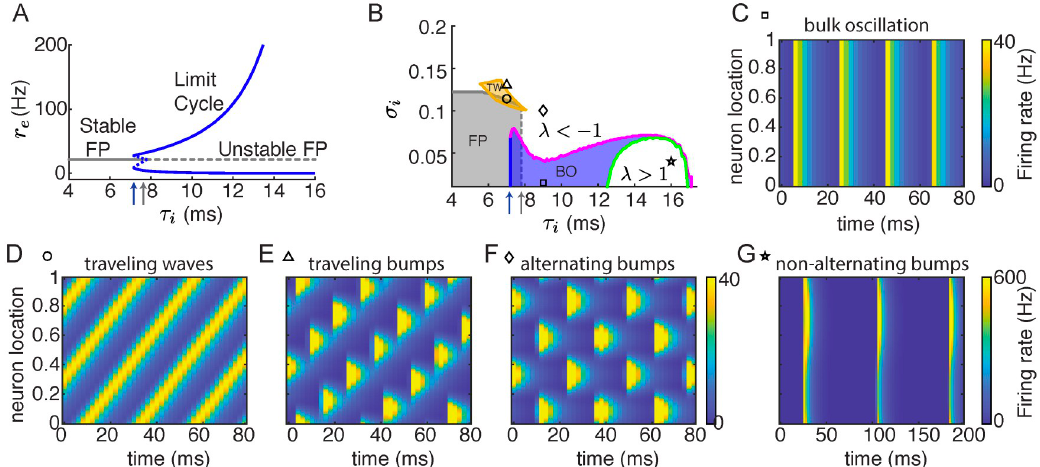
Fig 2. Dynamical regimes of networks with one-dimensional spatial coupling. A . Bifurcation diagram of the reduced two-unit model (Eqs 3 and 4) as τ i varies. Gray line, fixed point; blue curves, the maximal and minimal firing rates of a limit cycle; solid, with a limit cycle solution. The gray arrow indicates the Hopf stable; dashed, unstable. The blue arrow indicates the lowest τ i bifurcation (the largest τ i with a stable fixed point solution). B . Phase diagram of networks with one dimensional spatial coupling. Gray, stable fixed point; blue, stable bulk oscillation; orange, stable traveling waves. The fixed point solution loses stability at either the zero wave number (gray dashed line) or a nonzero wave number (gray solid line). The bulk oscillation loses stability with either an eigenvalue becoming larger than 1 (green curve) or an eigenvalue becoming less than -1 (magenta curve). Blue and gray arrows point to the same values of τ as in A . C-G Examples of the firing rate dynamics of the excitatory neurons in networks with i different τ i and σ i (the square, circle, triangle, diamond and star symbols indicate the parameters in panel B ). C , Bulk oscillation; D , traveling waves; E , traveling bumps; F , alternating bumps; G , non-alternating bumps. The temporal and spatial scales of the excitatory neurons are τ e = 5 ms and σ e = 0.1,